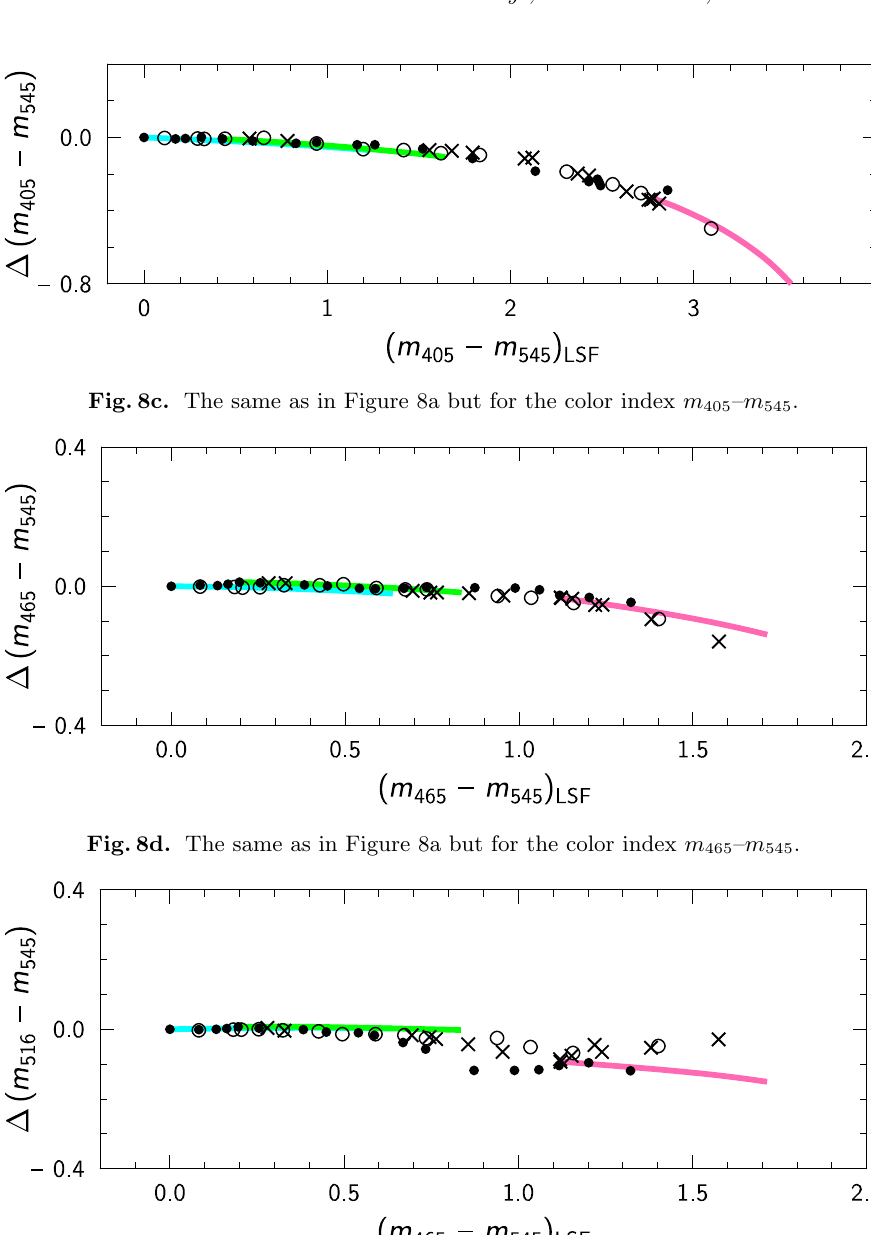
Fig. 8e. The same as in Figure 8a but for the color index m 516 – m 545